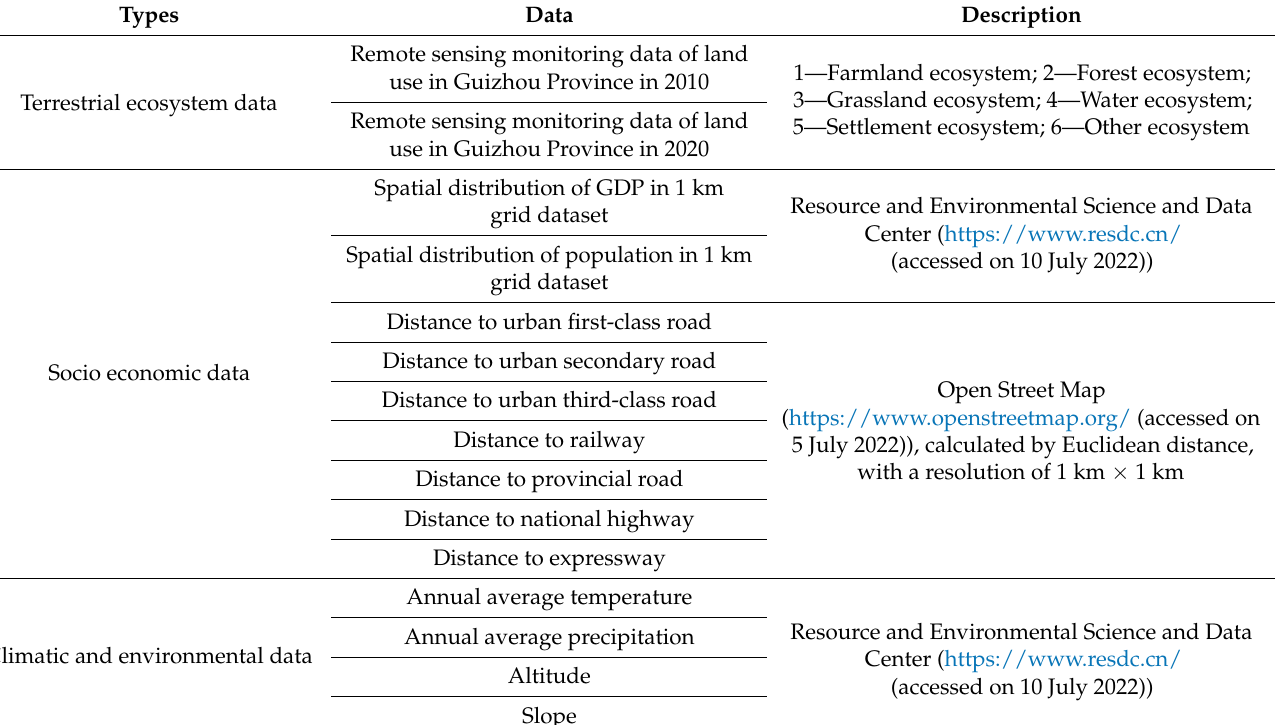
Table 2. Types and sources of land-use driving